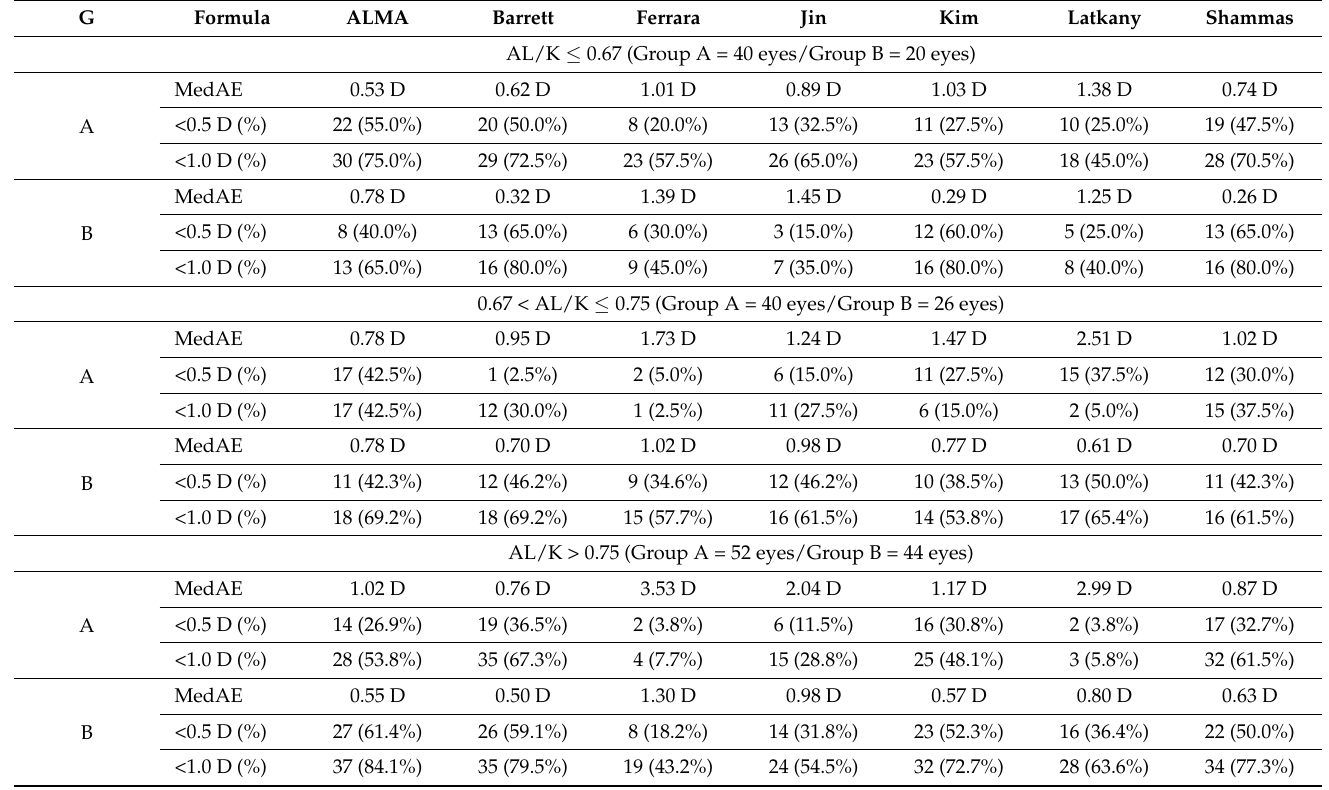
Table 4. Comparison of refractive outcome among examined formulas according to different axial length/mean keratometry ratio (AL/K)